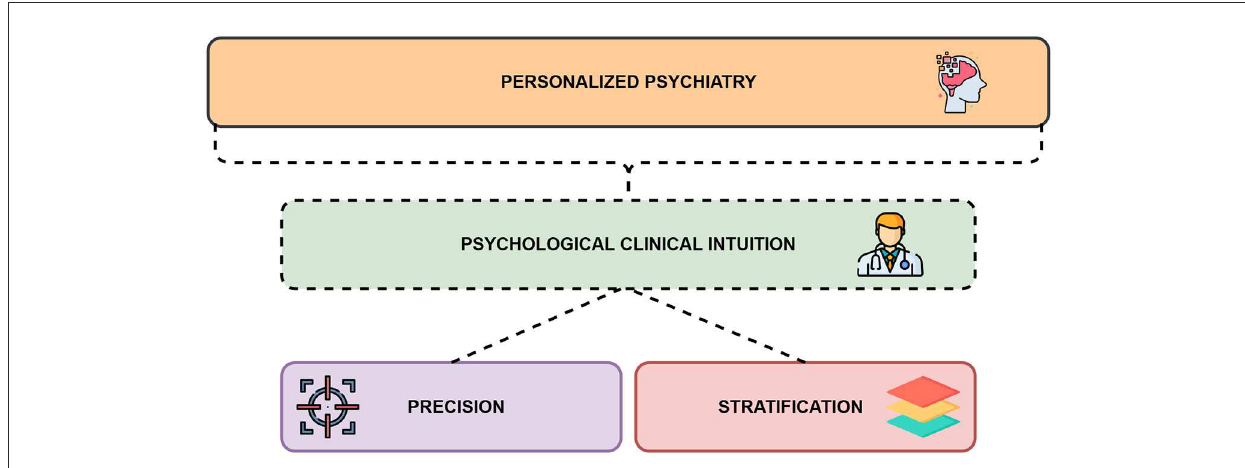
FIGURE1 A framework for understanding personalized psychiatry and psychological clinical intuition